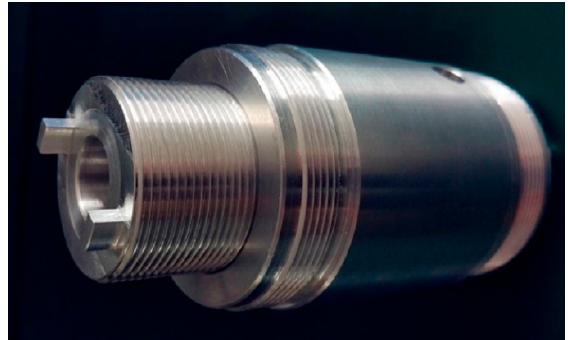
Figure 12. Photograph of the tunable neck to increase AEH efficiency. Reproduced with permission from [46]; published by ELSEVIER, 2017.